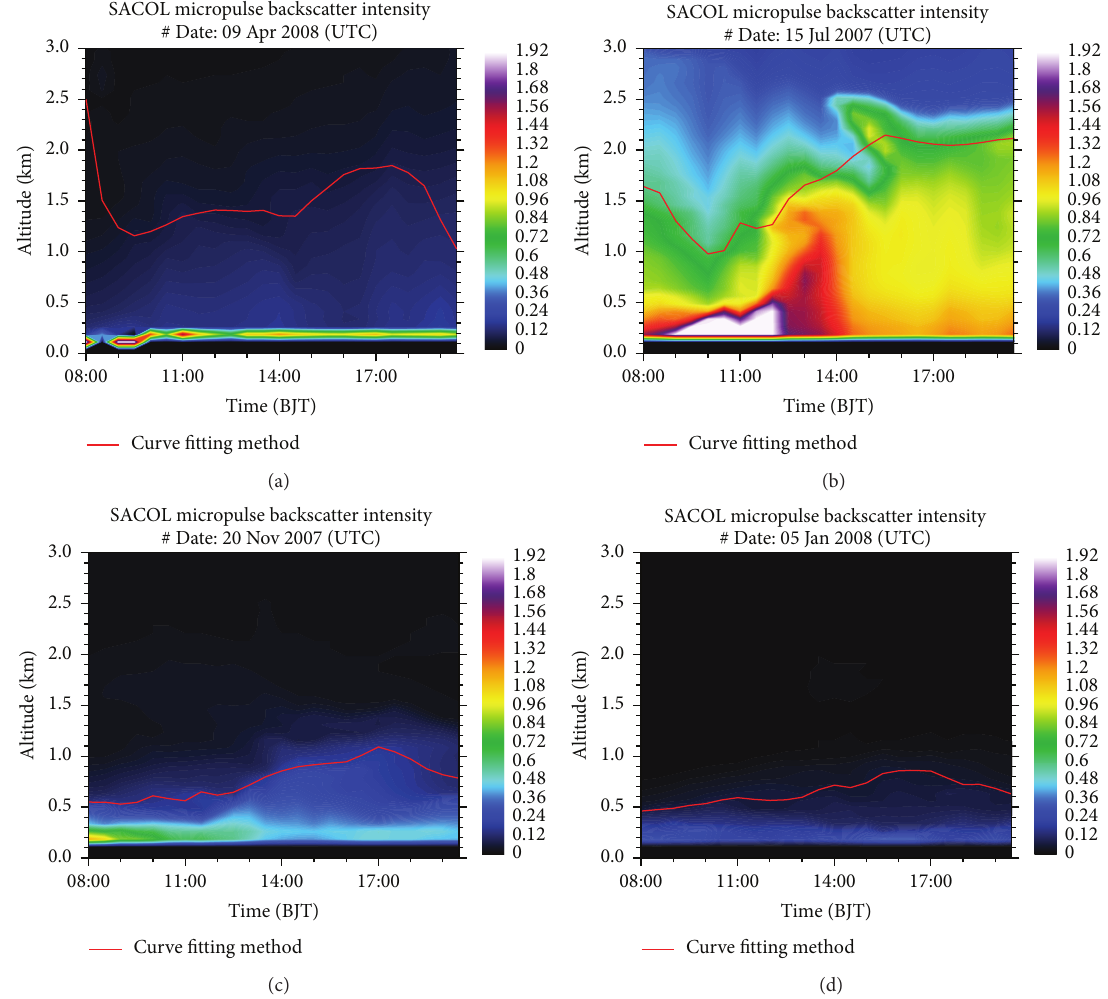
Figure 3: Time-altitude cross sections of the backscatter on (a) 9 April 2008, (b) 15 July 2007, (c) 20 November 2007, and (d) 5 January